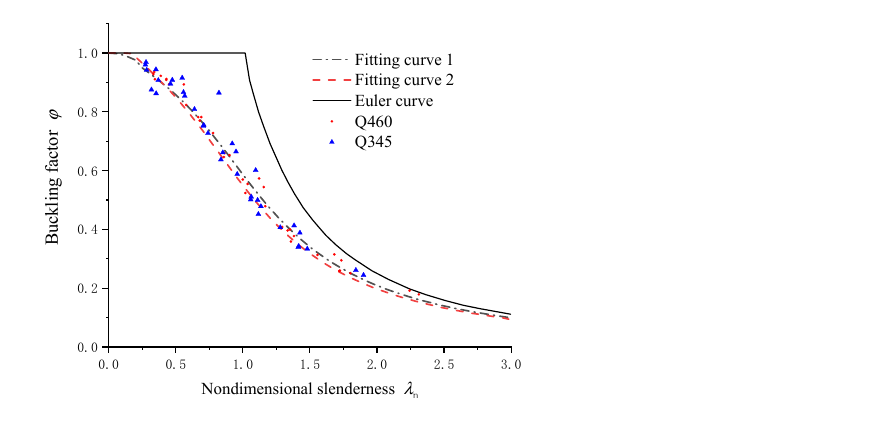
Figure 13. Comparison of FE results with proposed design curves.